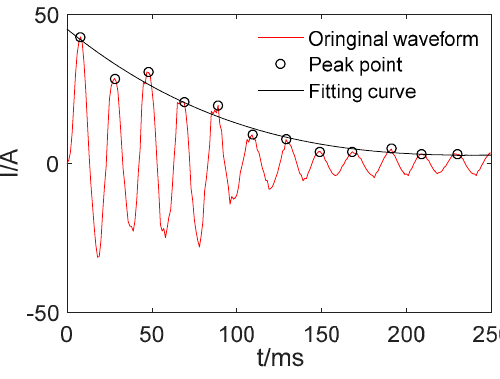
Figure 19. Original waveform and fitting curve.